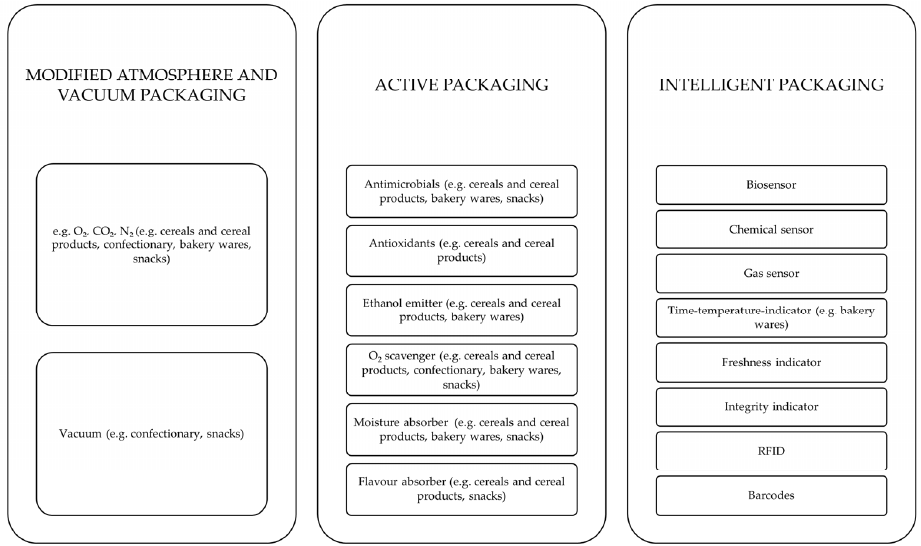
Figure 4. Selected examples of modified atmosphere, vacuum, as well as active and intelligent packaging approaches with certain use cases for cereal and confectionary packaging. Adapted from [13,108,117–140].